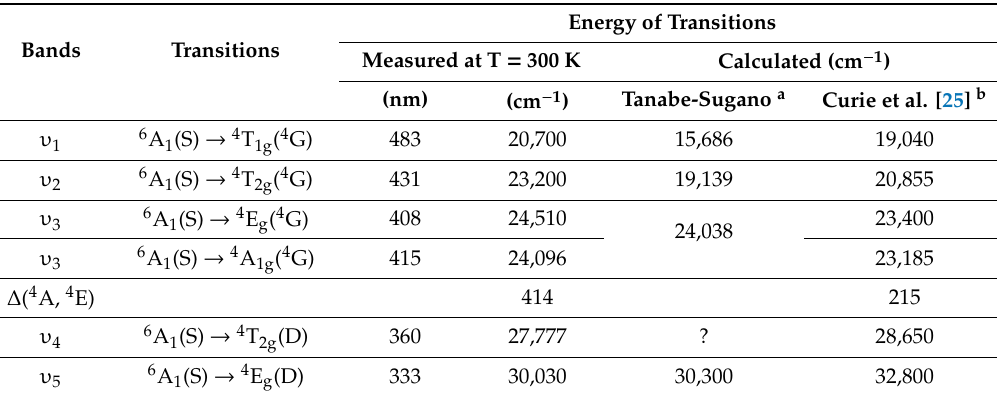
Table 2. Measured and calculated energies of absorption transitions of Mn 2 +